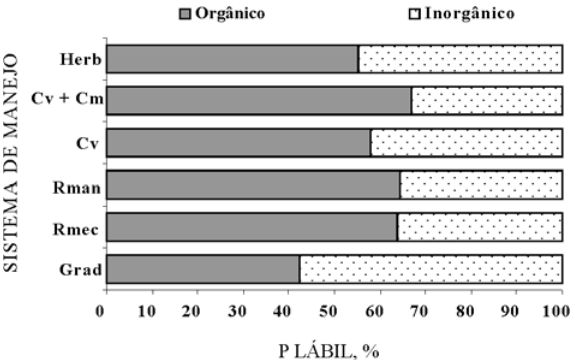
Figura 2. Distribuição percentual das frações lábeis do fósforo obtidas pelo fracionamento em meio ácido, determinado em amostras de um Argissolo Acinzentado cultivado com a cultura do cajueiro anão precoce, sob diferentes sistemas de manejo, no município de Pacajus, CE. Grad: gradagem + coroamento; Rmec: roçagem mecânica + coroamento; Rman: roçagem manual + coroamento; Cv: cobertura vegetal + coroamento; Cv + Cm: cobertura vegetal + cobertura morta; Herb: aplicação de herbicida (média de três